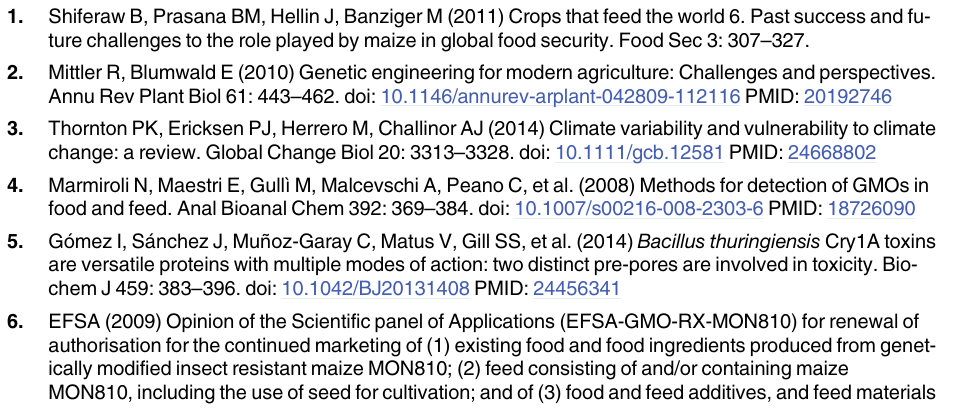
S1 Fig. Hierarchical clustering of global gene expression. Global gene expression was ob- tained through microarray analysis of the Tietar and DKC6575 samples taken from plants grown in the Field experiment at the developmental stage T2 in the drought stress condition and at T1 and T2 in the control condition. S2 Fig. Principal Component Analysis from the gene expression data set generated from the Tietar and DKC6575 samples. Each circle represents a sample at different stage. T1, con- trol condition for Tietar and DKC6575 (CONT1T, CONT1D) are represented as red circles; T2, control condition for Tietar and DKC6575 (CONT2T, CONT2D) are represented as blue circles, T2, drought stress condition for Tietar and DKC6575 (STRESST, STRESSD) are repre- sented as yellow circles. S1 Table. List of genes showing differential expression in Tietar and